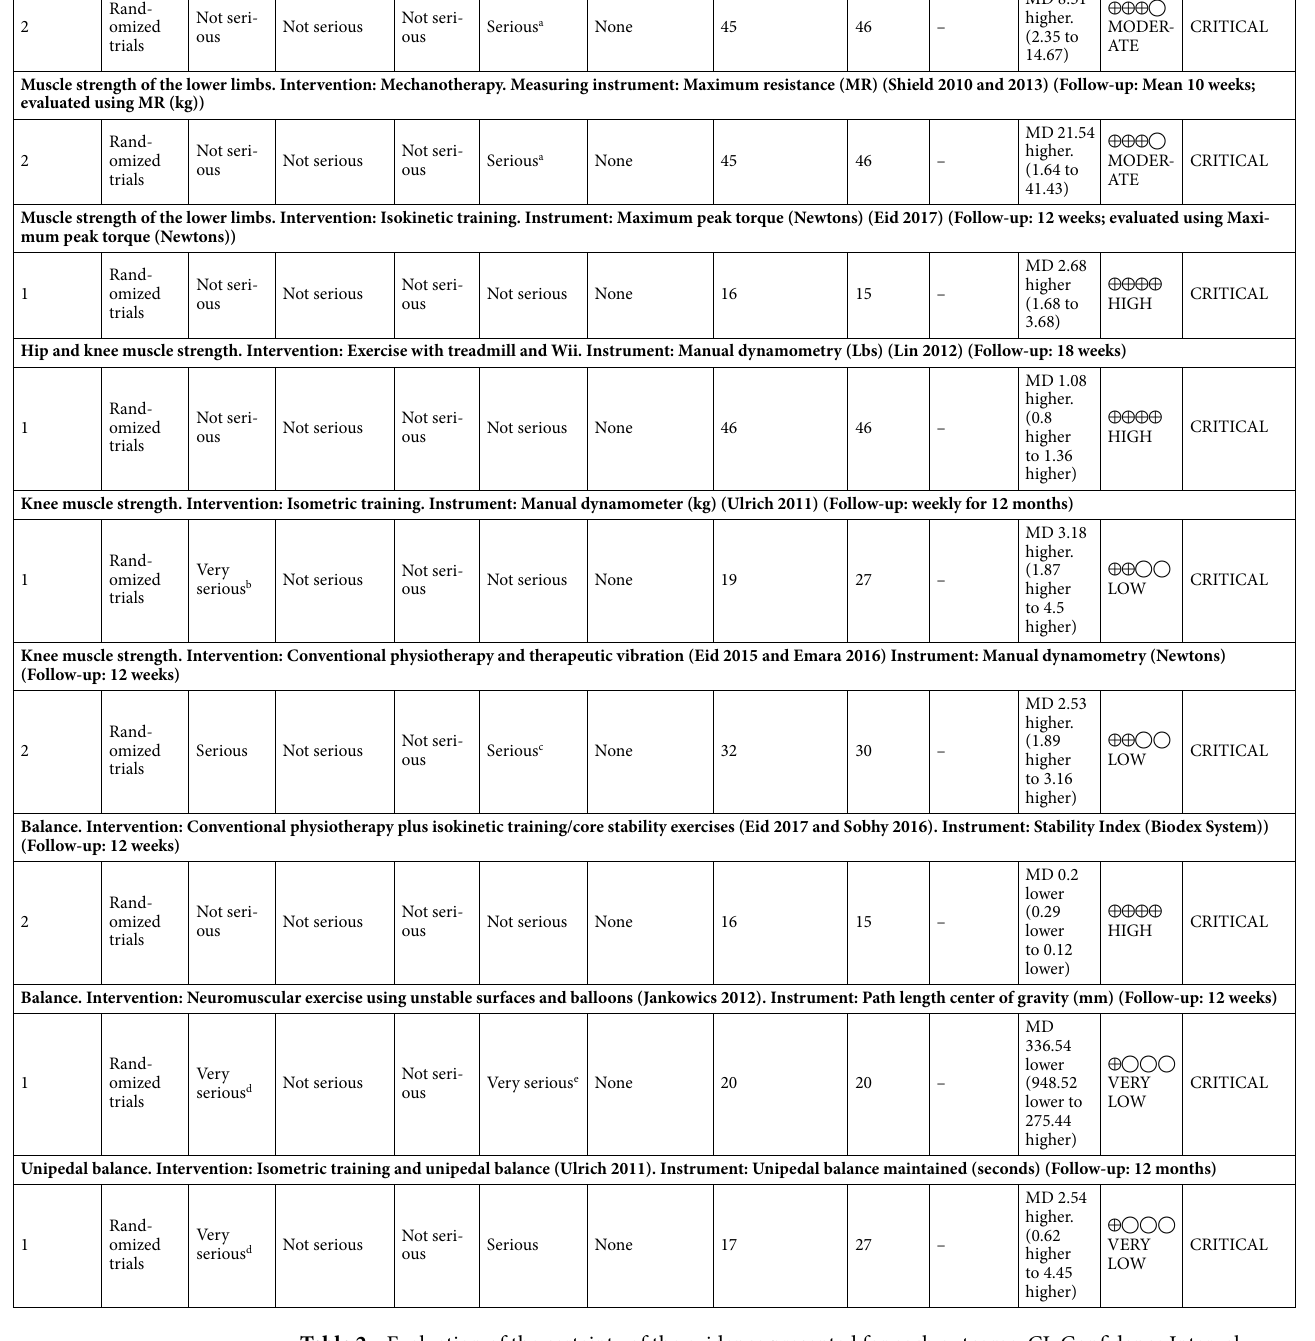
Table 2. Evaluation of the certainty of the evidence presented for each outcome. CI, Confidence Interval; MD, Mean Difference. Explanations. a Very wide confidence intervals. In one of the studies, the change is not statistically significant. b The trend is high risk 5/ 7. c Large confidence intervals. d High risk 5/7. e Very large confidence